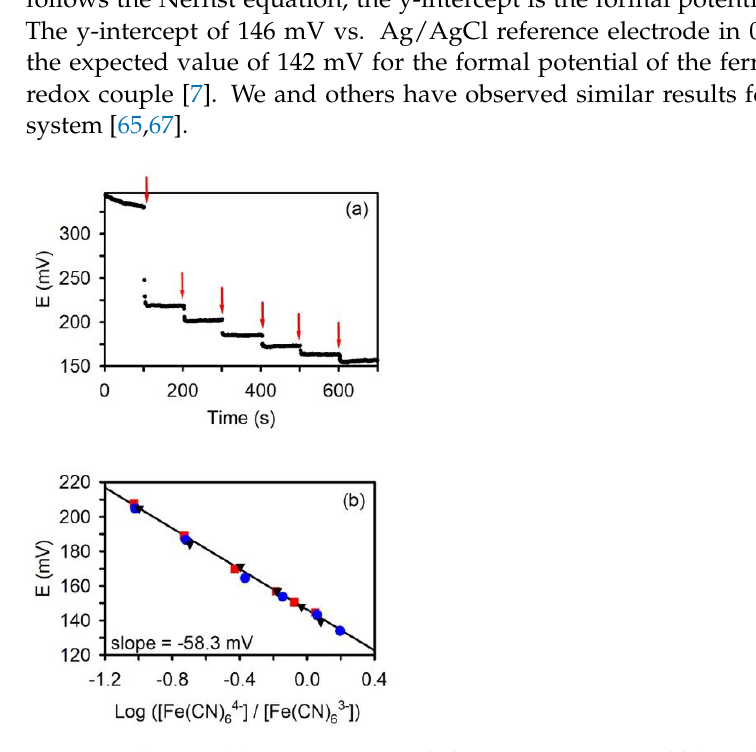
Figure 2. ( a ) OCP (E)-time trace recorded at a nanoporous gold (NPG) electrode following the addition of potassium ferrocyanide (signified by the red arrow) to a potassium ferricyanide receiving solution and ( b ) the corresponding Nernst plot. Each symbol represents a separate experiment with a different NPG electrode. The solid line represents the linear least-squares regression line. y = −58.3 mV + 146.0 mV. R 2 = 0.9965.